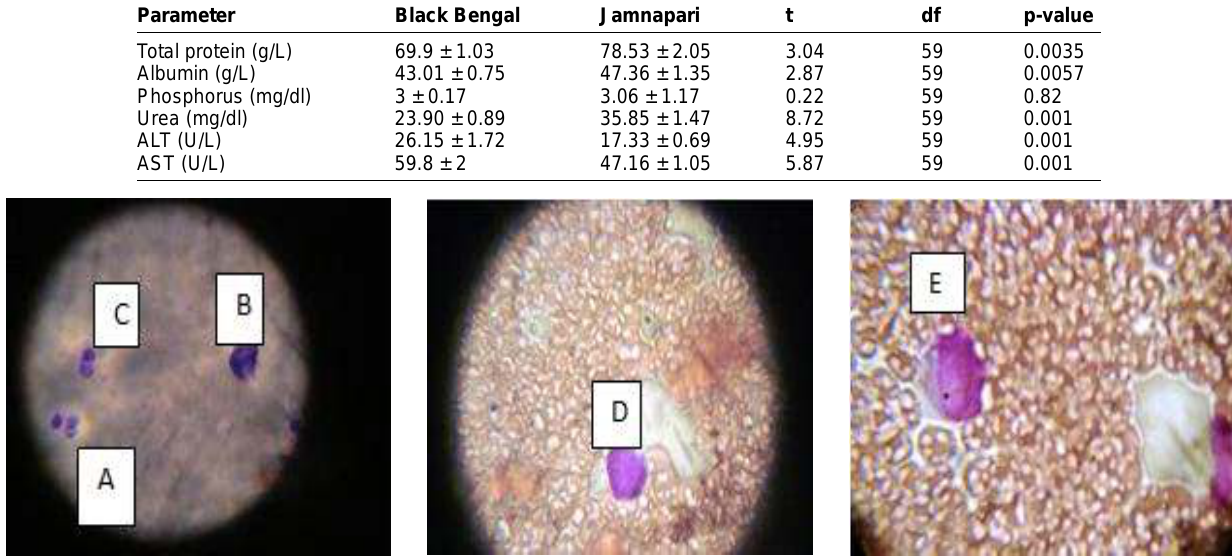
Figure. Differential leucocytes A. Neutrophil, B. Basophil, C. Eosinophil D. Lymphocyte, E. Table-3 and 4 shows that, among various Bengal and Jamnapari goats. haematological parameters, WBC, lymphocyte, PCV,